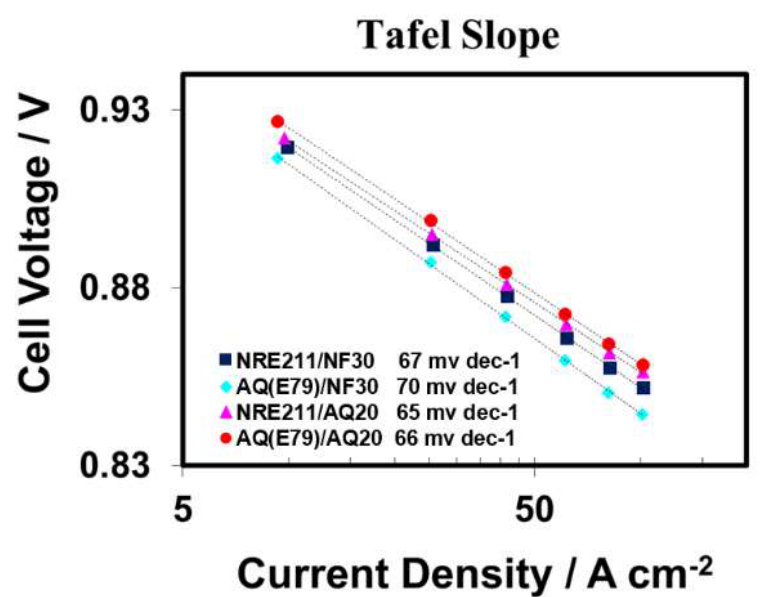
Figure 3. Tafel plots of H 2 /O 2 polarization at 80 °C and 100% RH for all investigated MEAs.